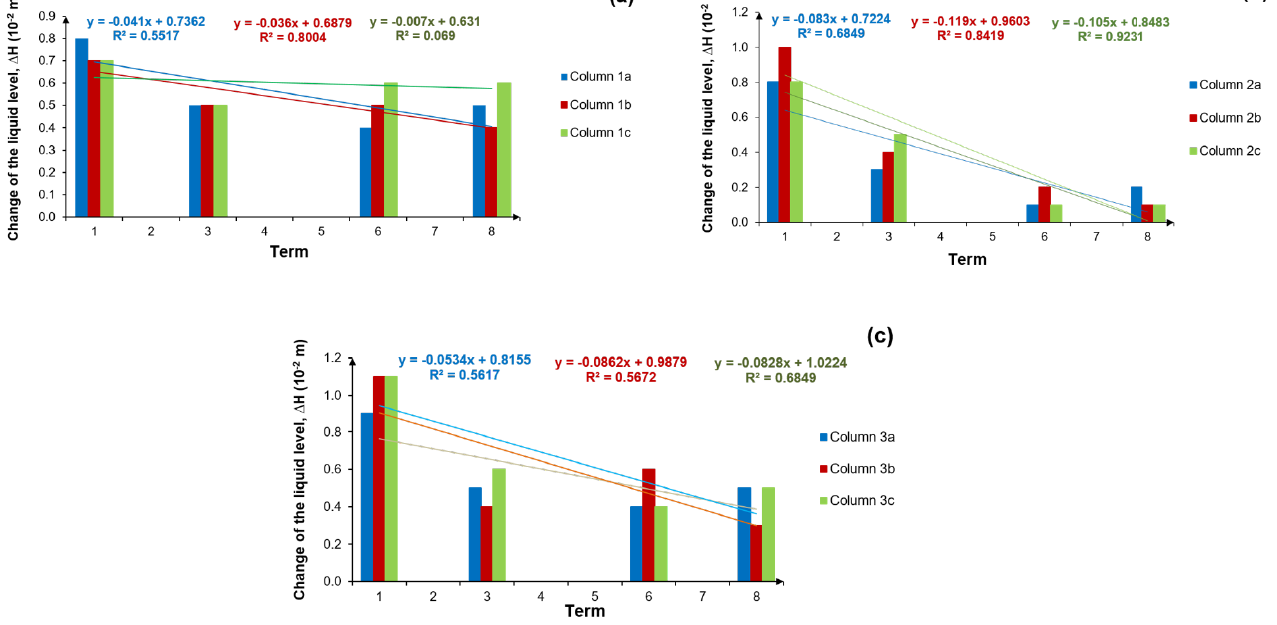
Figure 12. Difference in height between the initial water level and the level after 60 min ( ∆ H), for: ( a ) column group 1a, b, c supplied with treated wastewater, ( b ) column group 2a, b, c supplied with treated wastewater and brine solution periodically and ( c ) column group 3a, b, c supplied with tap water; terms from 1–8 represent the measurement periods after 1–8 regenerations.